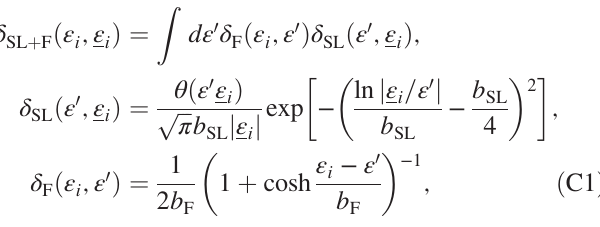
FIG. 15. All independent different-spin 4 p PSFs of the AIM, with the same parameters as used in Figs. 2(a), 2(b), 4, and 6. For all permutations O of O not listed here, the corresponding PSFs S p PSFs are obtained and narrowly broadened in the same way as in Figs. 2 and 3. The first and second rows show the PSFs as a function of ε ε ε 0 , the third and fourth rows as a function of ε 1 and 3 for fixed 2 ¼ PSFs S ; even rows show the connected PSFs S con . Each pair of the full and connected PSFs, with the same operators and frequency choices, are normalized by the maximum magnitude of the full PSF S in the pair. The dashed lines mark the Kondo temperature T =D ≃ 1 = 200 and the position of Hubbard side peak U= 2 ¼ 0 . 1 D K